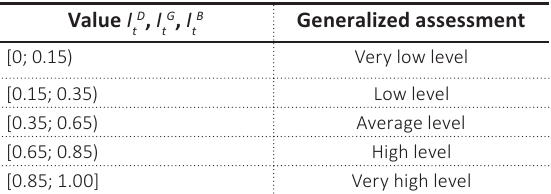
Table 1. Ranking of integral indicators of the depth of the deposit insurance system, implementation of the deposit